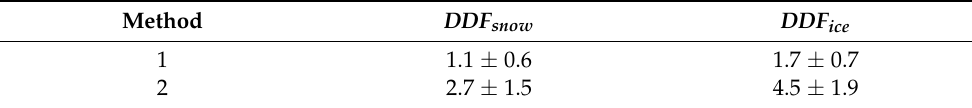
Figure 4. Tuned DDFs (mm° C − 1 day − 1 ) in Method 1 and Method 2. Red lines represent the observed mean ELA of 1127 m. Table 2. Tuned mean DDF values (unit: mm ◦ C − 1 day − 1 ) for snow and ice and their standard deviation in two DD methods. We used the means of snow and ice plus and minus one standard deviation in the DDF simulations up to 2200 to generate an uncertainty envelope.